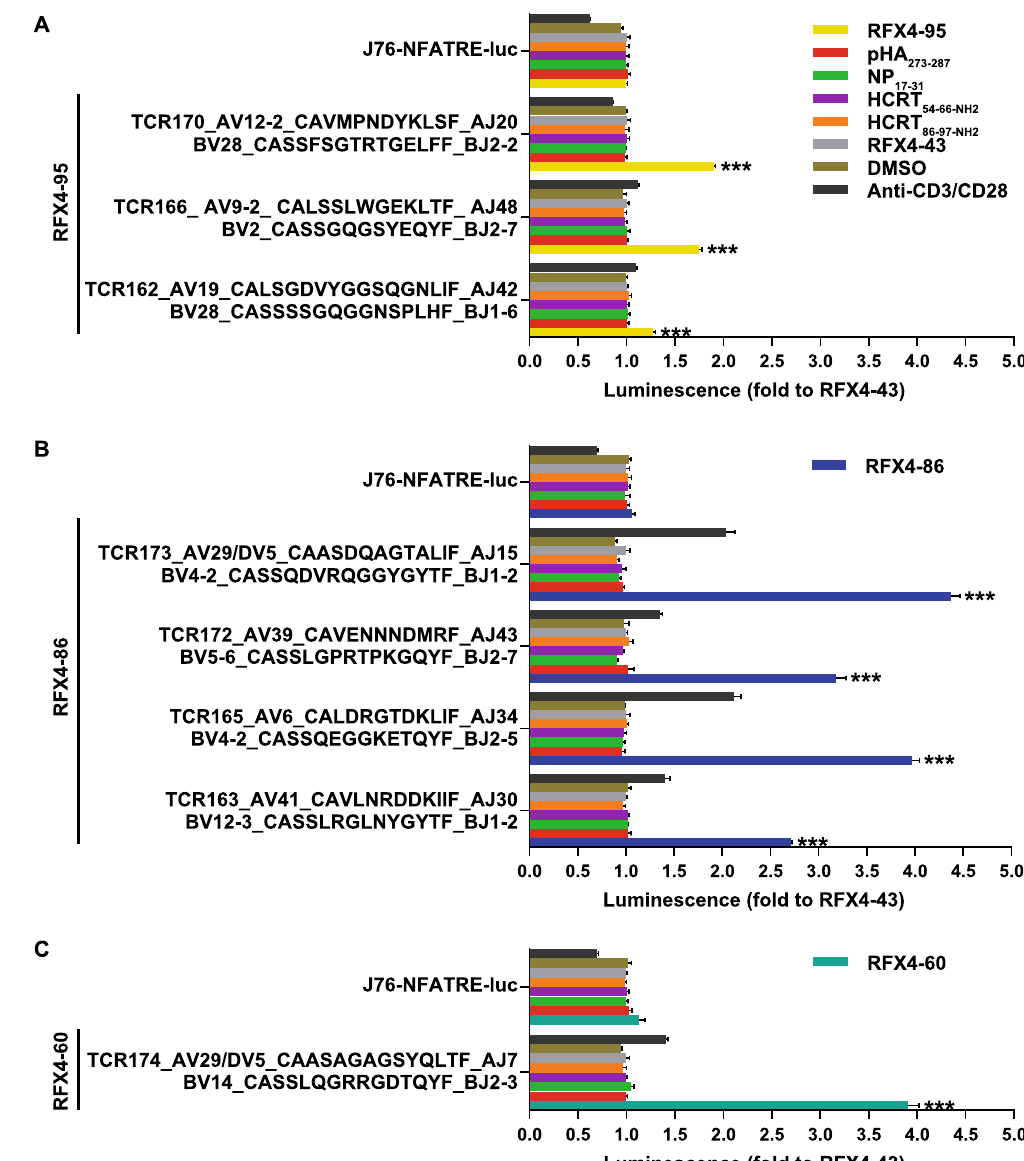
Figure 3. Activation of TCR signaling by RFX4 antigens presented by DQ0602. Jurkat 76-NFATRE-luc cells were transfected with TCRαβ and then co-cultured with RM3-DQ0602 presented with 10 µM of pHA 273–287